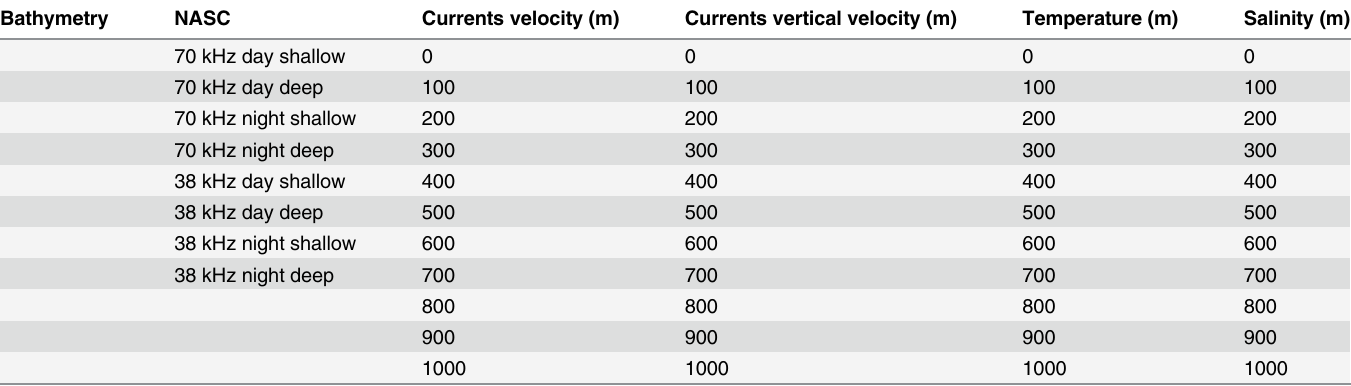
Table 2. Summary of all covariates considered in the whale GAMMs: bathymetry, NASC values for 8 components of the micronekton from cruise data, currents absolute and vertical velocities, temperature and salinity at 11 depth levels from a general circulation model.